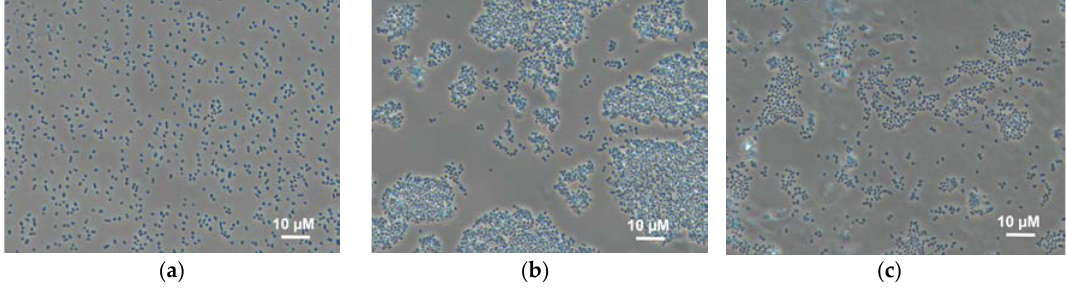
Figure 3. Micrographs of Gluconobacter oxydans cells in polymer gels: ( a ) chitosan; ( b ) PVA; ( c ) mPVA.